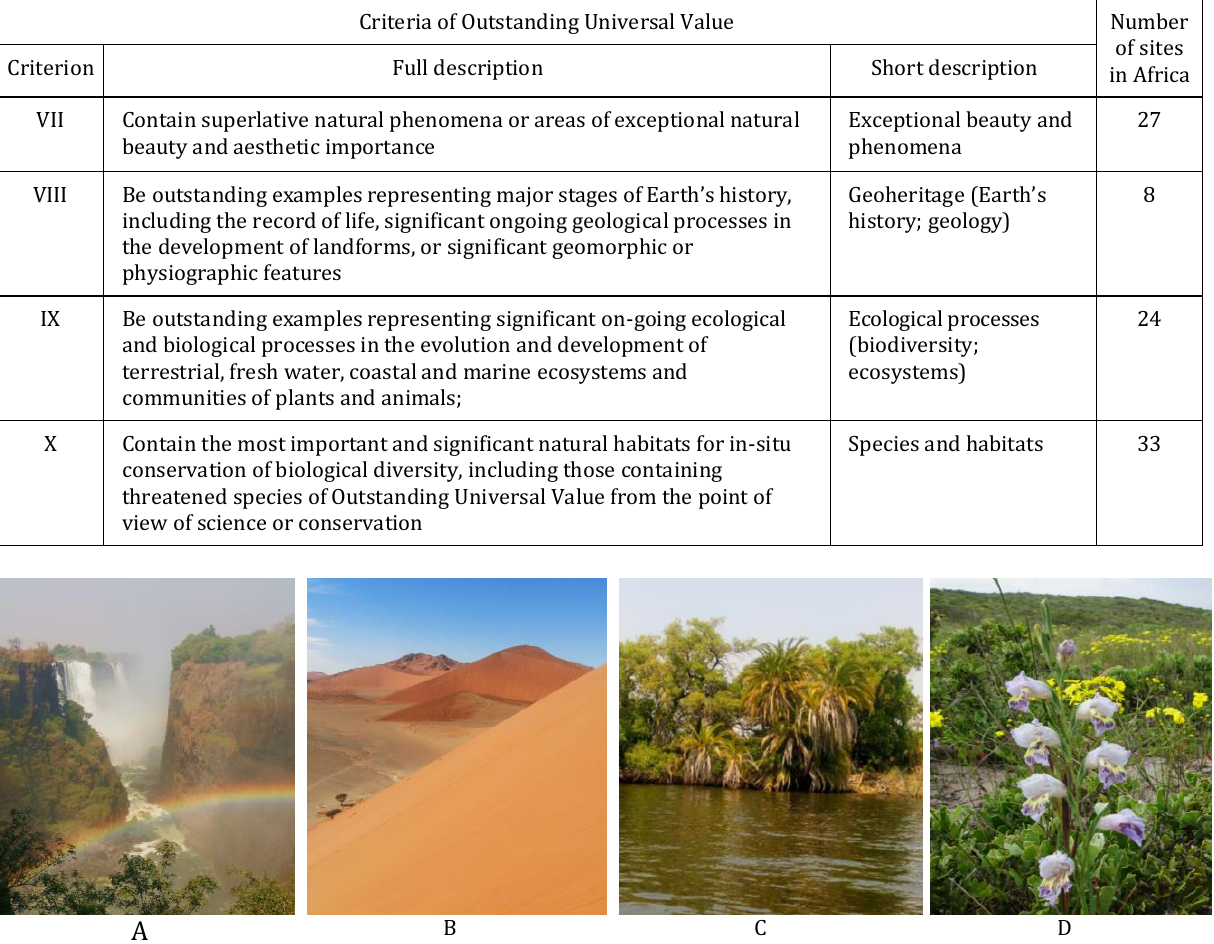
Fig. 2. Examples of World Heritage sites in Africa according to criteria of Outstanding Universal Value A – Criterion VI: Mosi-oa-Tunya/Victoria Falls, Zambia/Zimbabwe; B – Criterion VIII: Namib Sand Sea, Namibia; C – Criterion IX: Okavango Delta, Botswana; D – Criterion X: Cape Floral Region Protected Areas, South Africa ( Photos R. Dulias